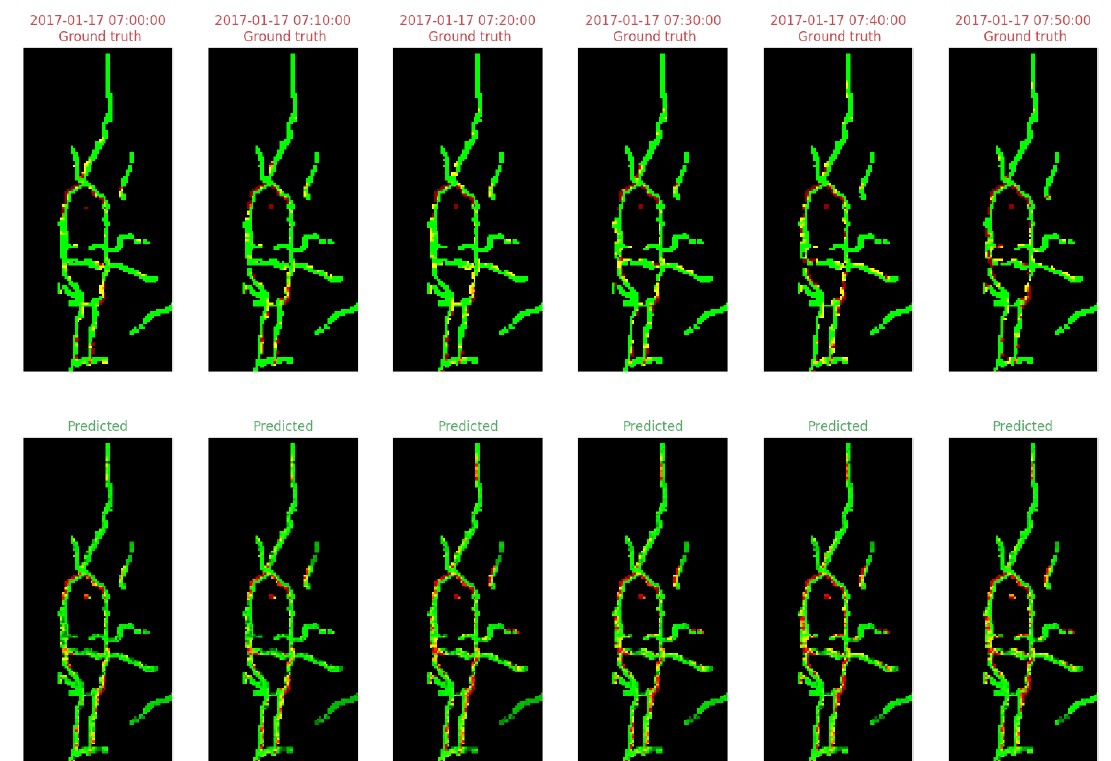
Figure 6. Ground truth congestion levels (first row) vs. predicted congestion levels (second row) on 17 January 2017 with a prediction horizon of 10